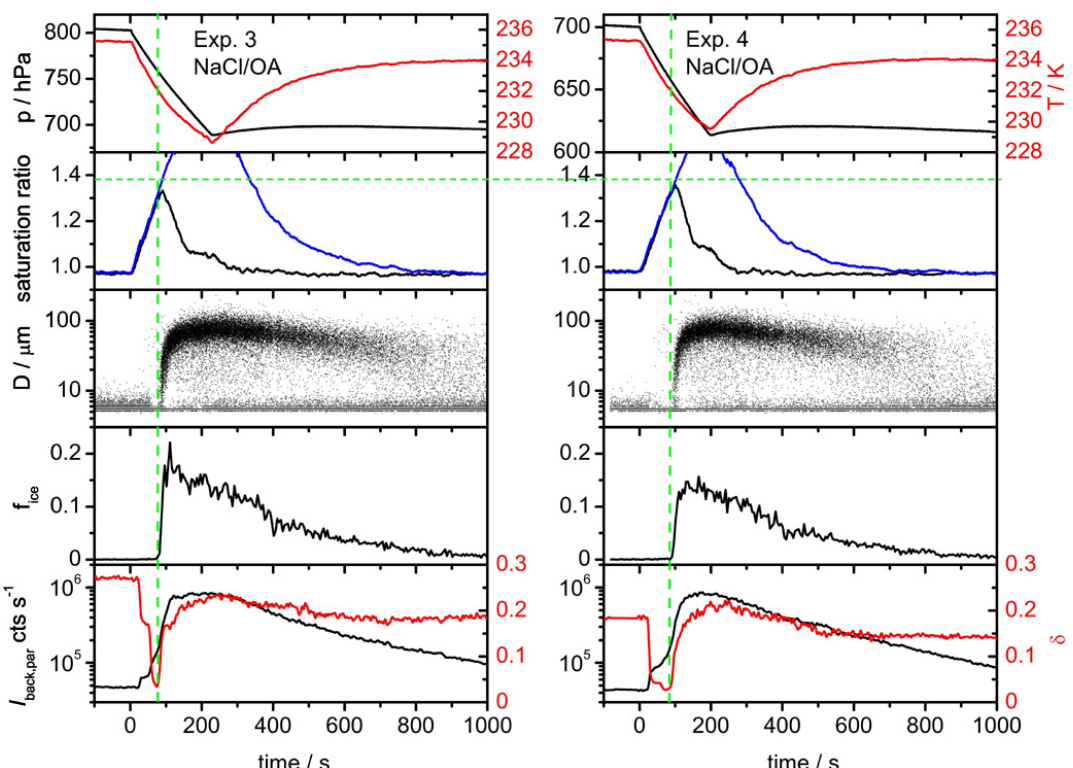
Fig. 11. Time series of various AIDA records during the second expansion cooling cycles from Exp. 3 and Exp. 4 that were started at 235K. The individual panels contain the same measurements as in Fig. 7. The horizontal green line connecting the second row panels denotes the critical ice saturation ratio for homogeneous freezing of aqueous NaCl solution droplets, as detected in the second expansion cooling cycle of Exp. 1 (Fig. 7, left